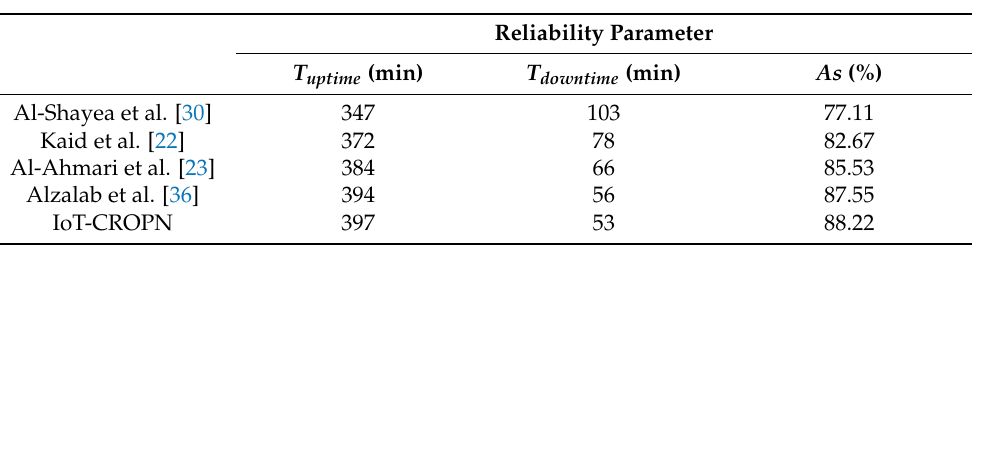
Table 4. The parameters of the reliability for the IoT-CROPN shown in Figure